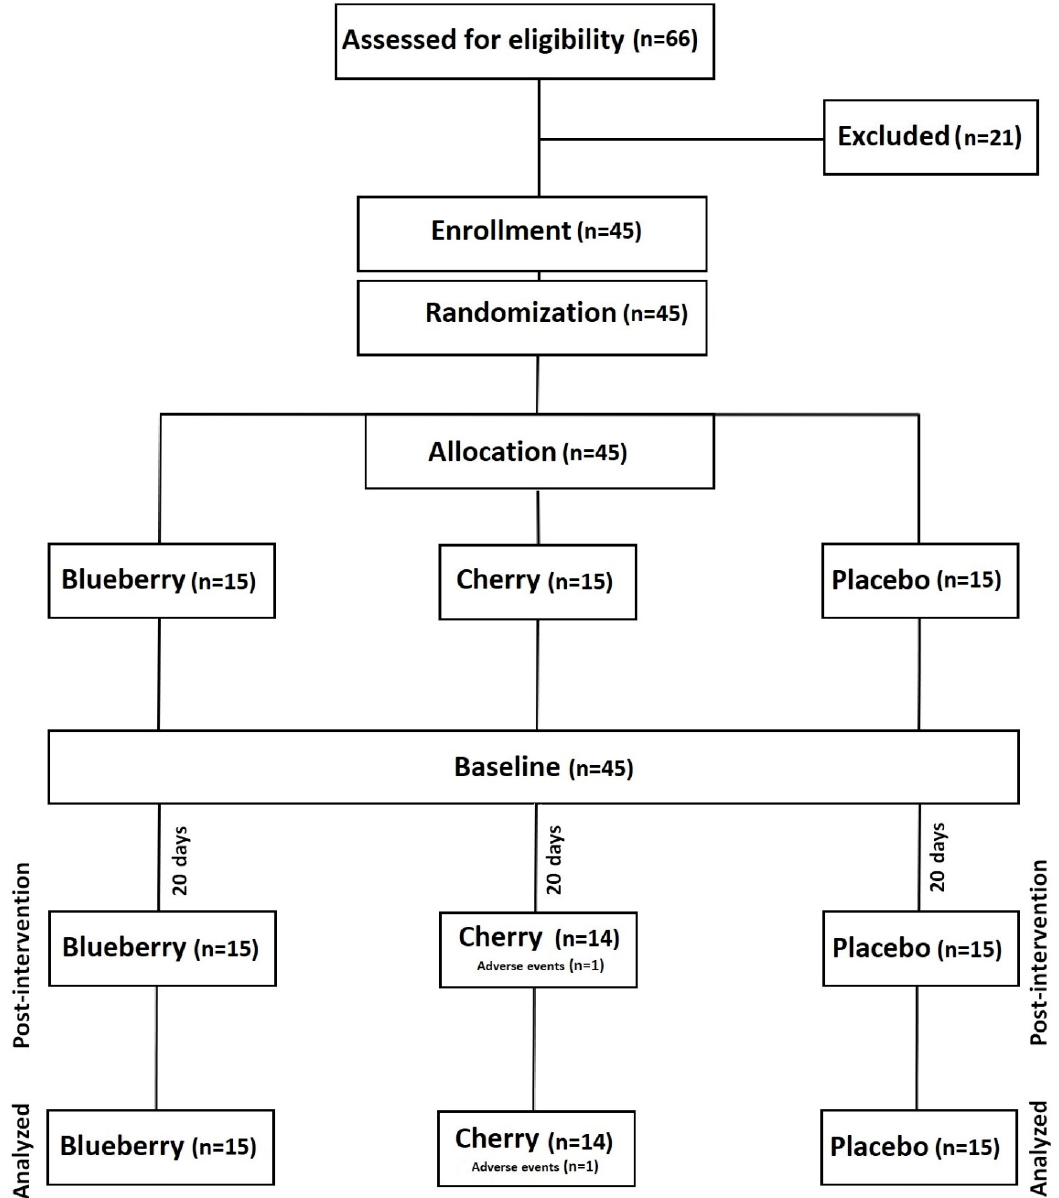
Figure 2. Consort diagram showing of participant flow throughout the study. There was no statistically significant difference in % compliance between the placebo and cherry ( b = 1.47, (95% CI = − 1.01–3.95), t = 1.21, p = 0.24), placebo and blueberry ( b = 0.80, (95% CI = − 1.70–3.30), t = 0.66, p = 0.52), or between cherry and blueberry groups ( b = 0.67, (95% CI = − 1.45–2.79), t = 0.64, p = 0.53). For supplementary anthocyanins, however, there were significant differences between the placebo and cherry ( b = 6059.52, (95% CI = 5966.31–6152.73), t = 132.77, p < 0.001, η P 2 = 0.98), placebo and For supplementary daily sugars, there were significant differences between the placebo and cherry ( b = 17.04, (95% CI = 16.78–17.30), t = 132.66, p < 0.001, η P2 = 0.98), placebo and